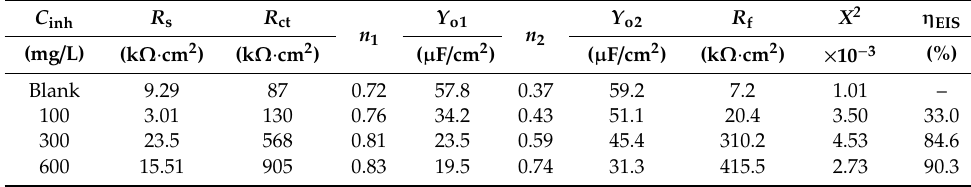
Table 1. Electrochemical impedance parameters in the absence and presence of di ff erent concentrations of GG-AMPS at 308